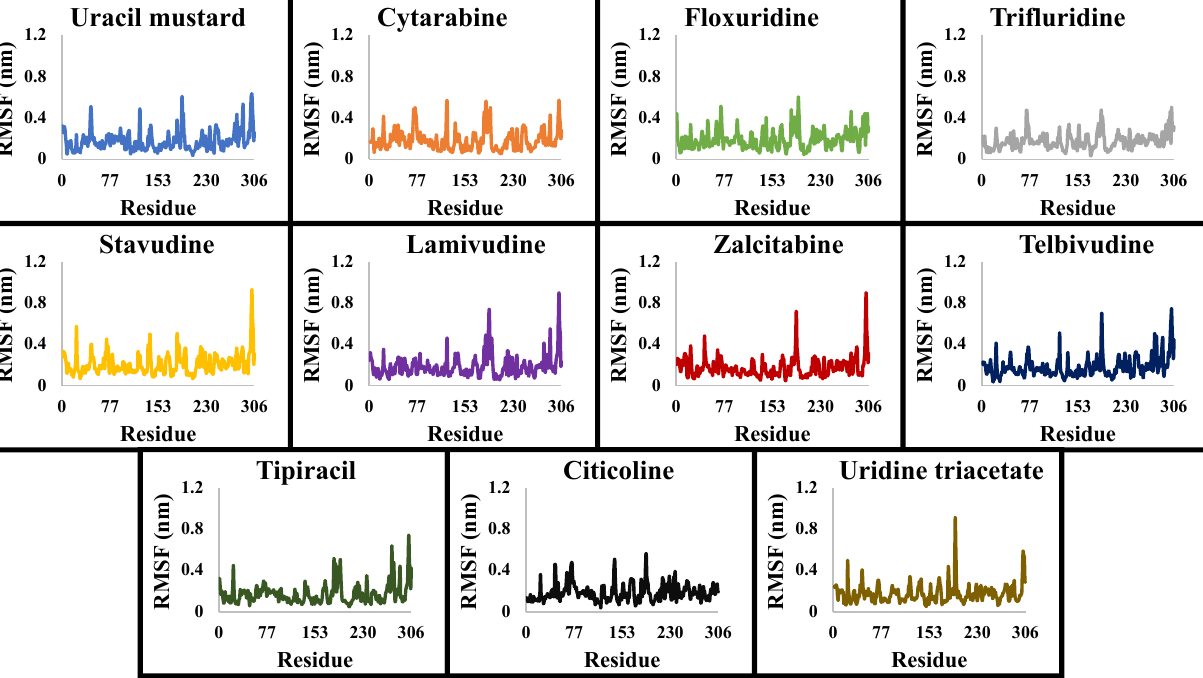
Figure 4. The RMSF values of the simulated PP-3CL pro complexes throughout the 200 ns production runs.